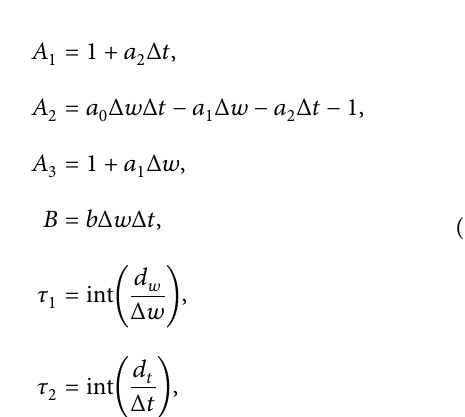
( n , n ) at k � 5 , 10 , 15 , 40 by using the ILC law k 1 2